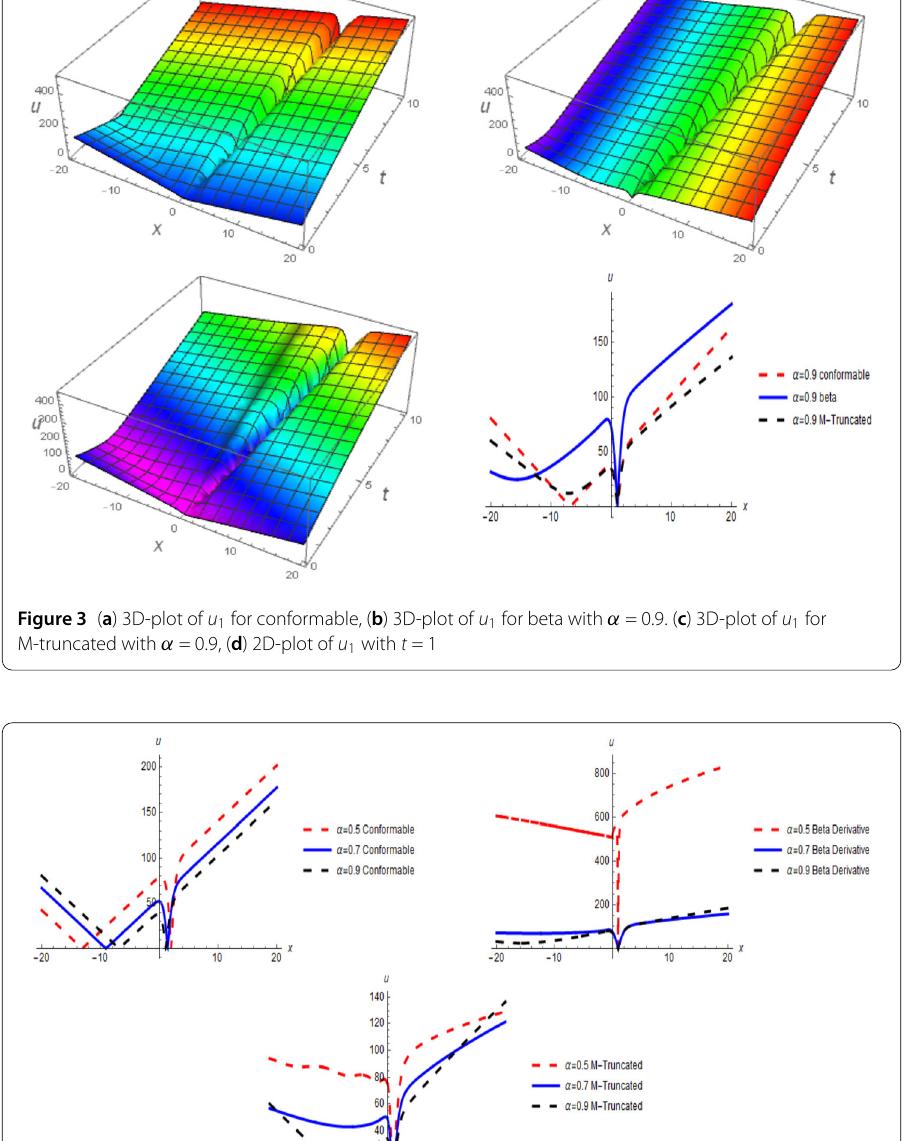
by using different definitions of derivatives. It is observed that at t = 1 all definitions lead to different structures. The amplitude of soliton is much higher as compared to other two definitions with the same value of fractional parameter α . Figure 2: In this figure, we take a = 1, ρ = 2, c = 1, α = 0.7, κ = 1, λ = 1, ν = 1, v = 1, k = 1, P = 1, θ = 1 in u 1 ( x , t ) where 2(a) shows its 3D structure for conformable derivative, 2(b) presents its graphs with beta derivative, 2(c) shows a 3D graph at β = 0.9 with M-truncated derivative, and 2(d) is for the 2D-graph of u 1 ( x , t ) at t = 1